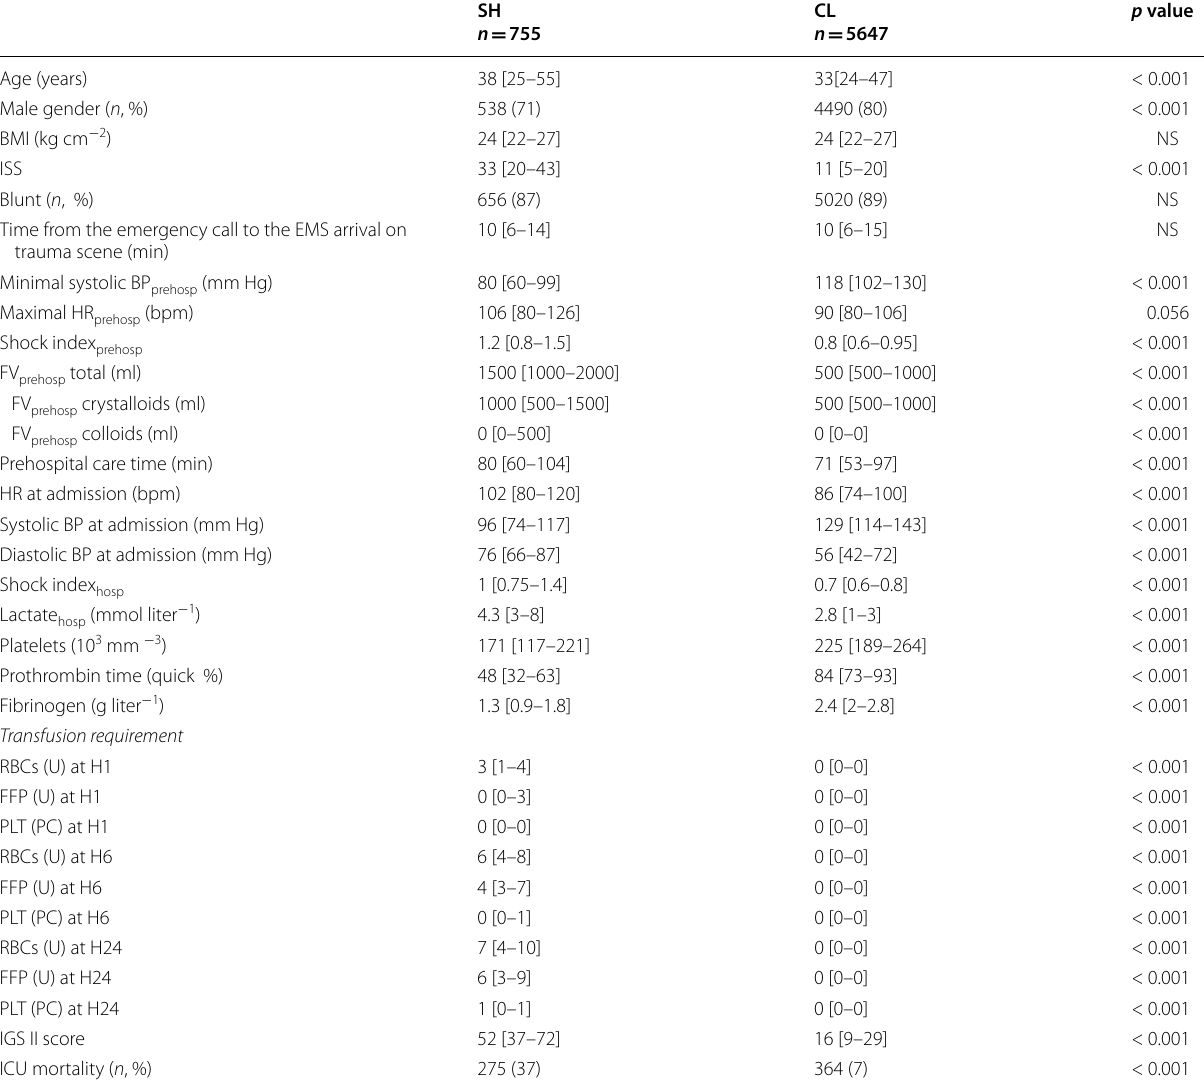
Table 1 General characteristics for patients with significant hemorrhage and